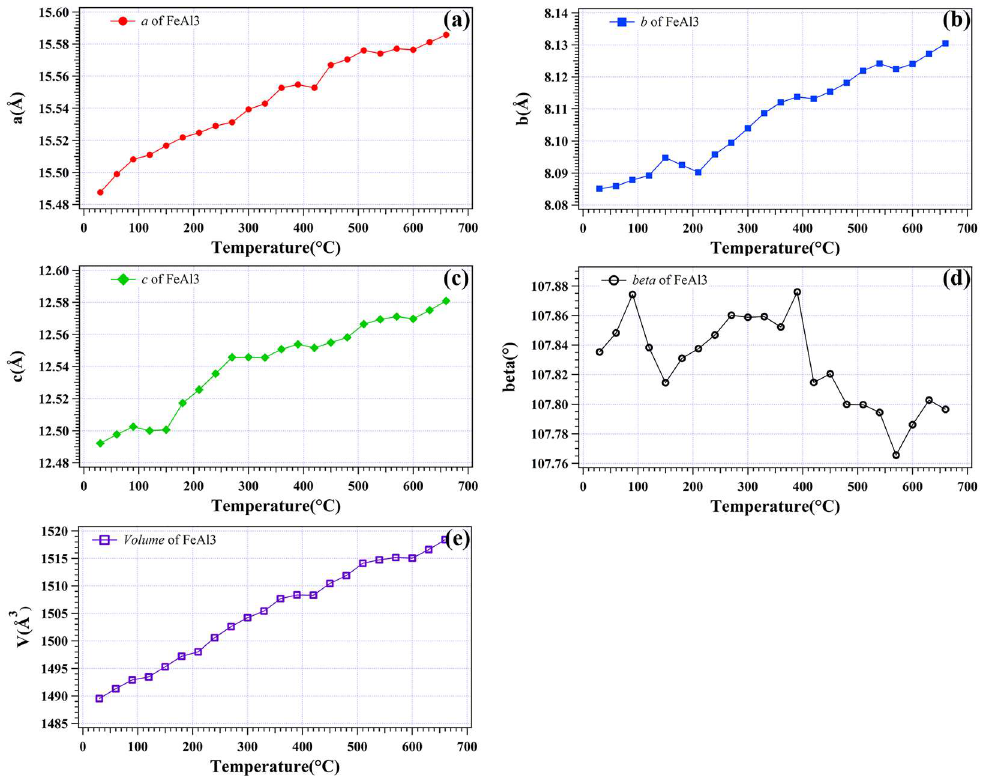
Figure 5. Lattice parameters for the FeAl 3 monoclinic lattice based on the size ( a ) a , ( b ) b , ( c ) c , ( d ) beta and ( e ) unit cell volume in the dross